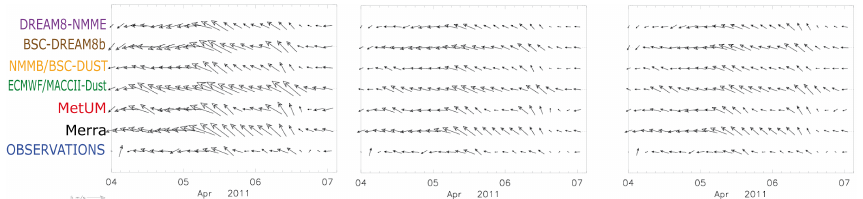
Figure 10. Time series of near-surface wind speeds in dust source region. Three-hourly values of the 10m wind speed from observations and reanalysis (MERRA) and global models and regional models for the period 4–7 April 2011 with (a) 24h, (b) 48h and (c) 72h lead times. Observations are averaged over the region illustrated in Fig. 1. The 10m winds from the models are averaged over the grid boxes enclosing the observation